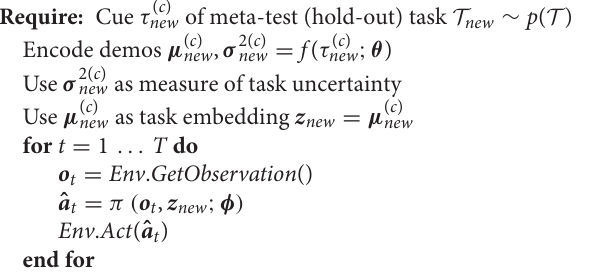
Algorithm 2 : Meta-test of